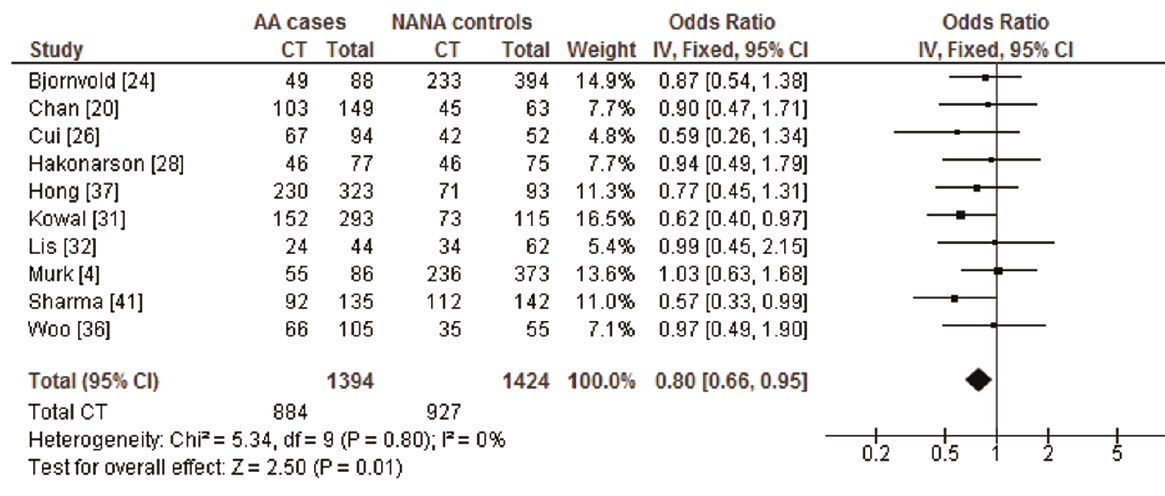
Figure 3 Forest plot of CD14 -260 ( -159 ) CT versus CC genotypes for studies with precisely defined phenotypes . The forest plot displays the meta-analysis results of studies included in the review that used atopic asthma versus non-atopic non-asthma case-control phenotypes, excluding heterogeneous studies identified by sequential analysis [11,27,42]. Meta-analysis was conducted using an inverse variance (IV), fixed effects model. For each study in the forest plot, the area of the black square is proportional to study weight and the horizontal bar represents the 95% confidence interval (CI). Atopic asthma and non-atopic non-asthma are abbreviated as AA and NANA,